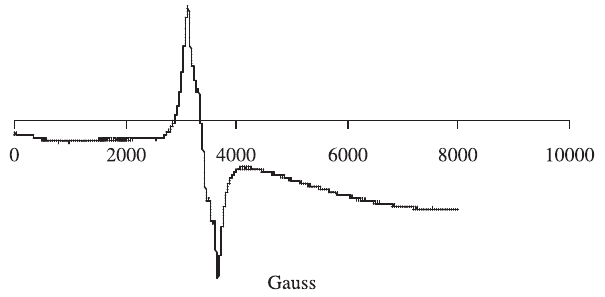
Figure 6. Electron spin resonance spectroscopic analysis of mesoporous Mn – organophosphate molecular sieve.